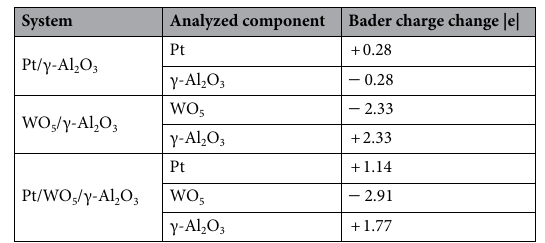
Table 3. Bader charge change of Pt, WO 5 and the γ-Al 2 O 3 component in the Pt/γ-Al 2 O 3 , WO 5 /γ-Al 2 O 3 , and Pt/WO 5 /γ-Al 2 O 3